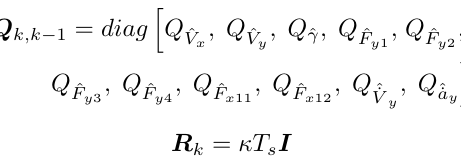
Fig. 5: Vertical forces from CarSim and calculation.